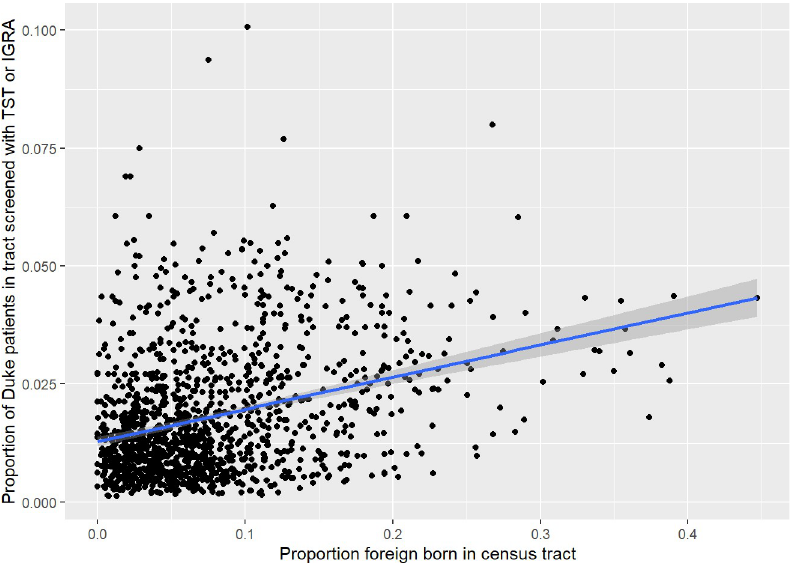
Fig 3. Regression model for proportion of higher-risk foreign-born living in a census tract and percentage of Duke University Health System patients living in that tract screened with TST or IGRA, January 1, 2010 to October 31,